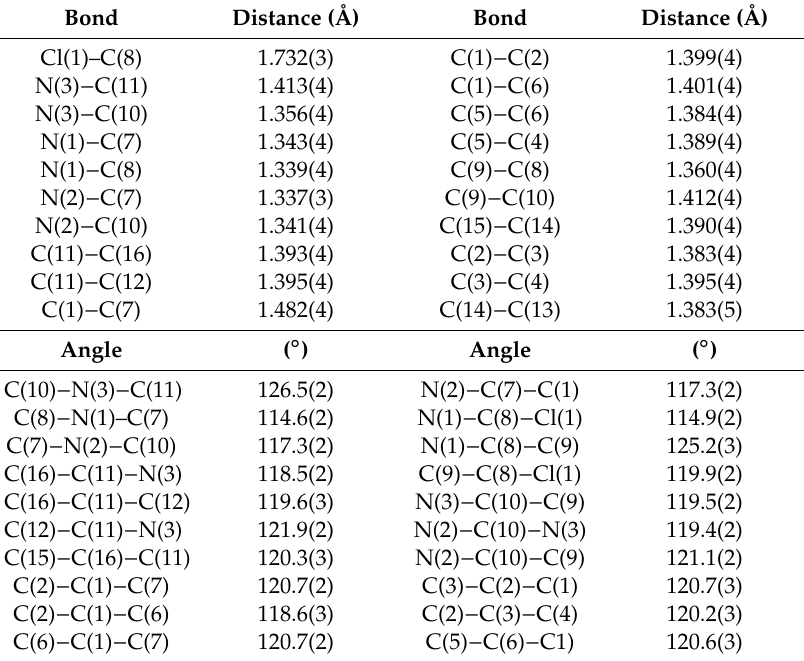
Table 3. Selected bond lengths (Å) and bond angles ( ◦ ) for compound